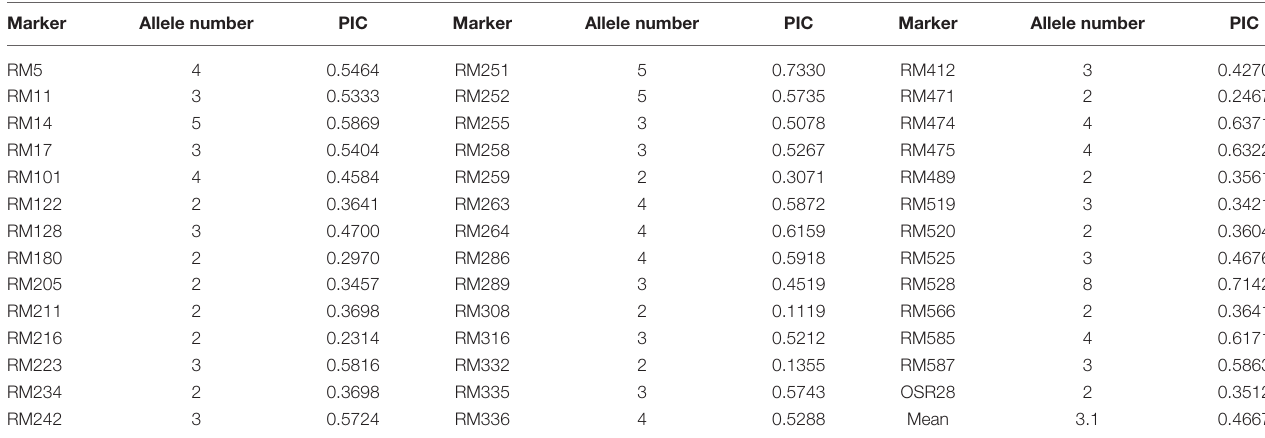
TABLE 3 | The genetic diversity of SSR markers in glutinous rice. Marker Allele